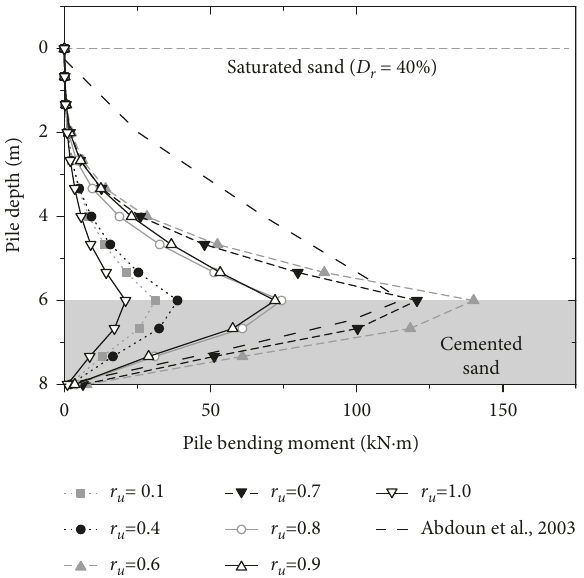
Figure 5: The comparison of computed results and test